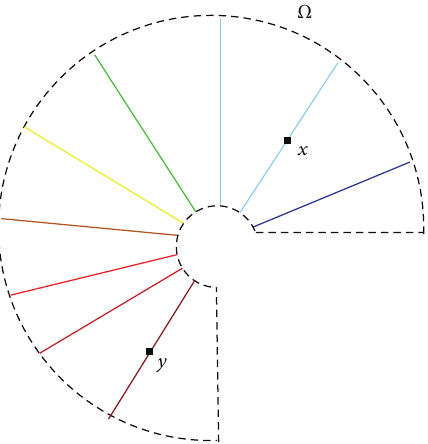
Figure 14: A function that is not 𝐾 monotone, but is Normal